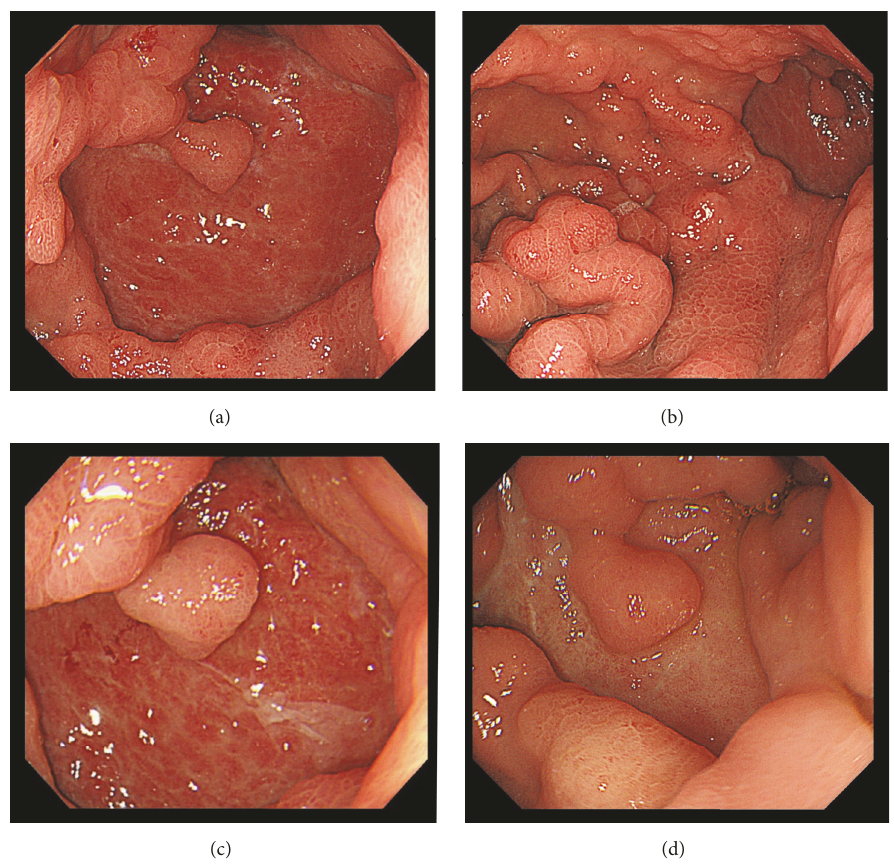
Figure 4: (a) day 37 post-ESD, (b) day 37 post-ESD, (c) day 51 post-ESD, and (d) 4 months